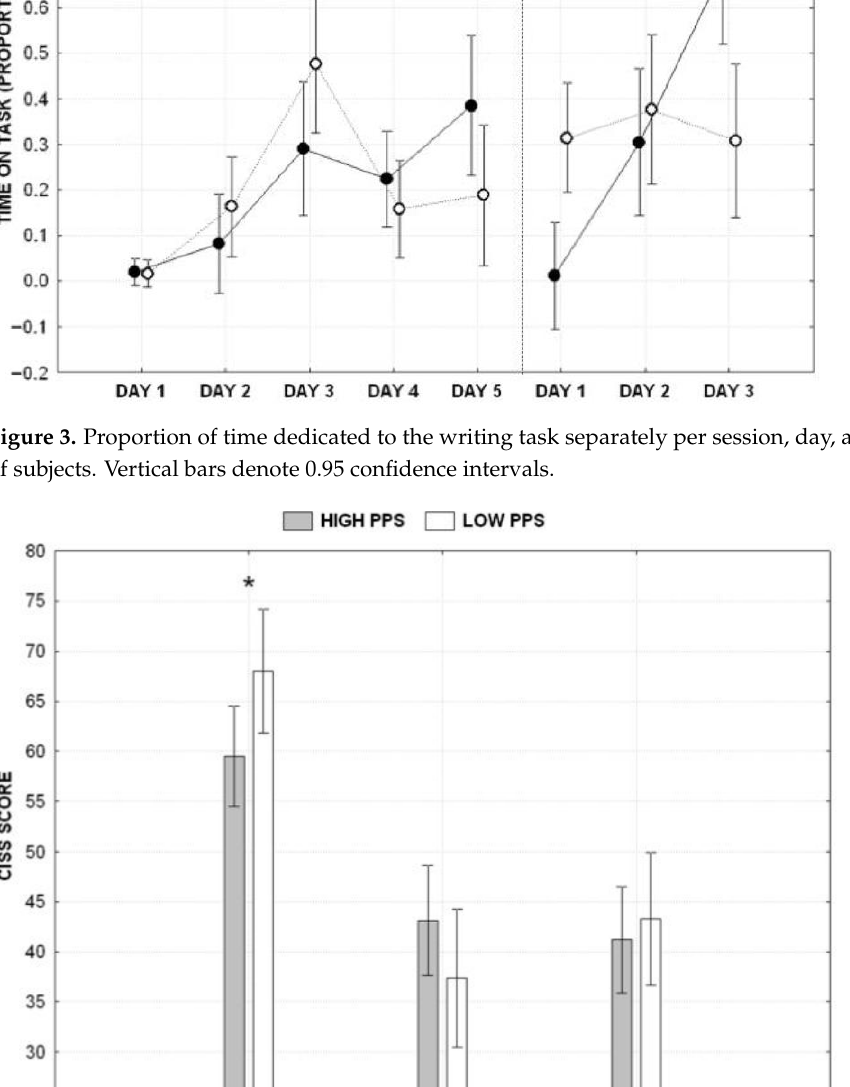
Figure 3. Proportion of time dedicated to the writing task separately per session, day, and category of subjects. Vertical bars denote 0.95 confidence intervals.